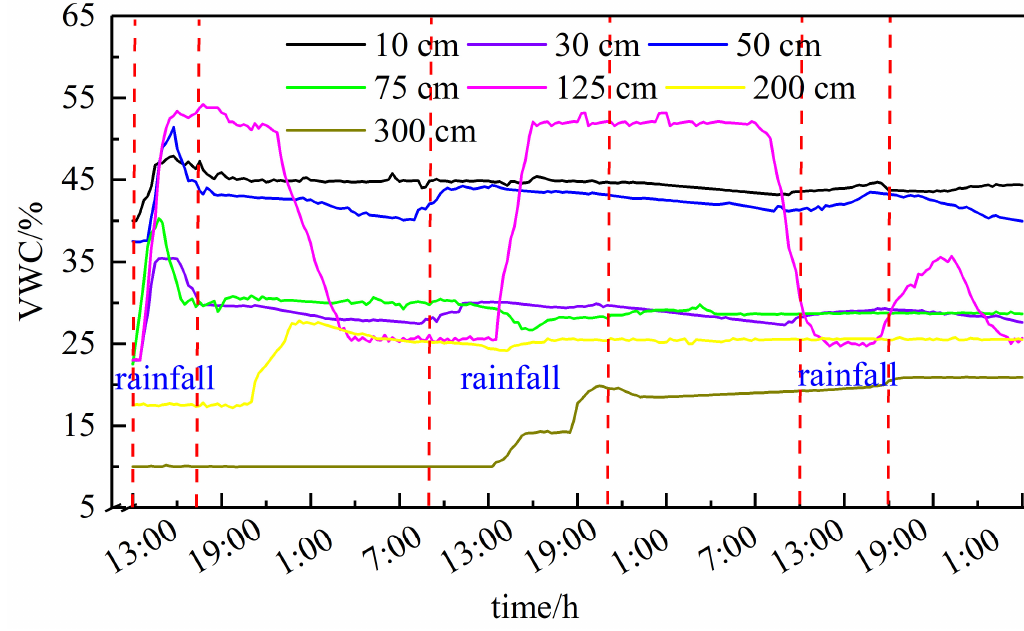
Figure 6. Time-varying curves of volumetric water content under the first condition.